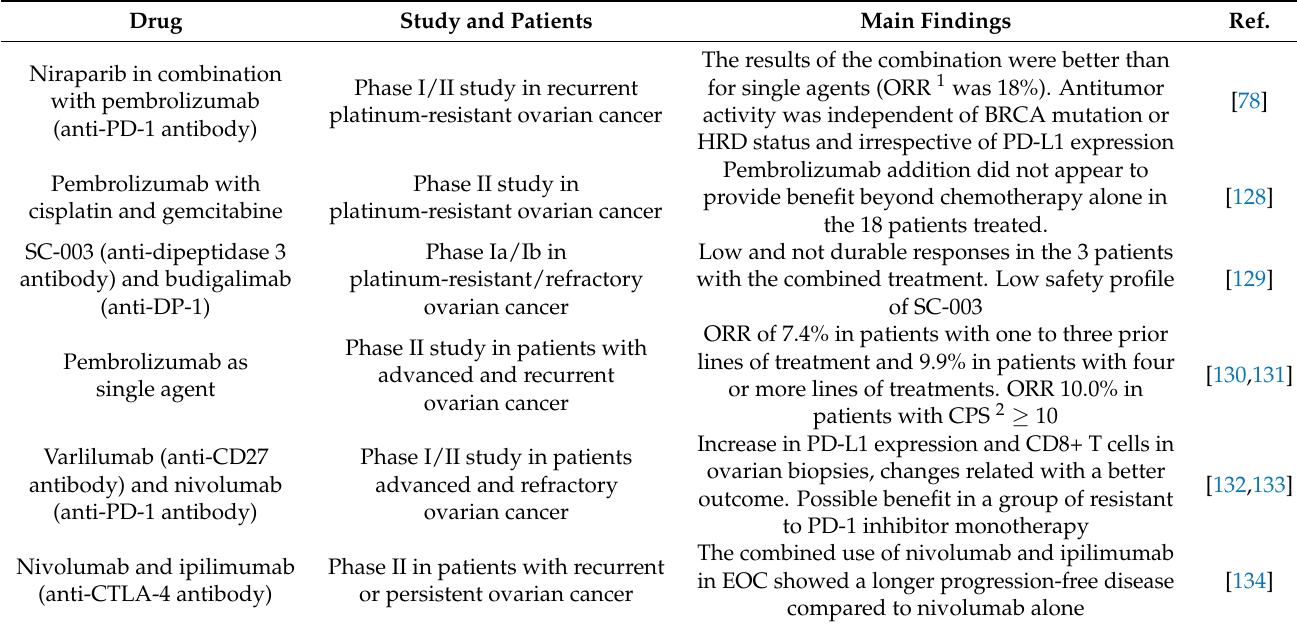
Table 3. Summary of clinical trials using inhibitors of immune checkpoints with published results in ovarian cancer